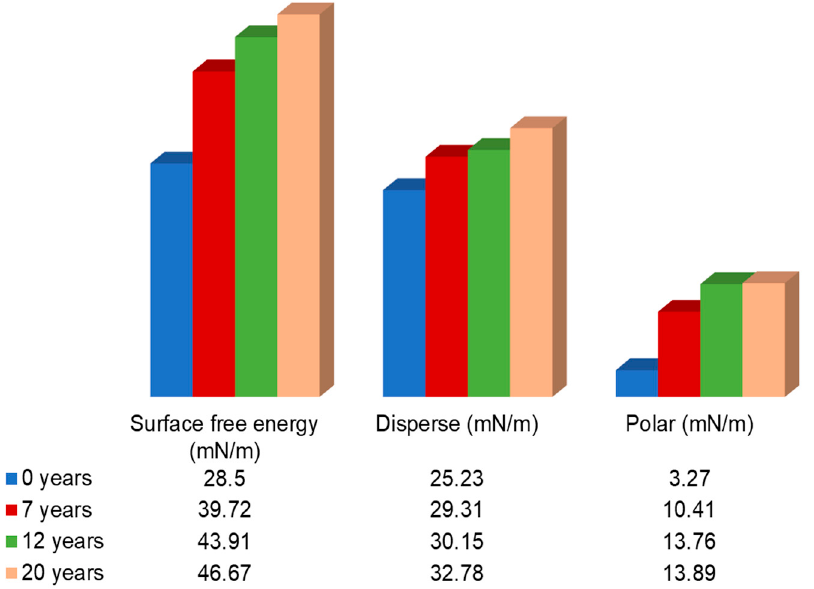
Figure 7. Surface free energy, dispersion, and polarization of epoxy primer-coated specimens exposed for different numbers of years.